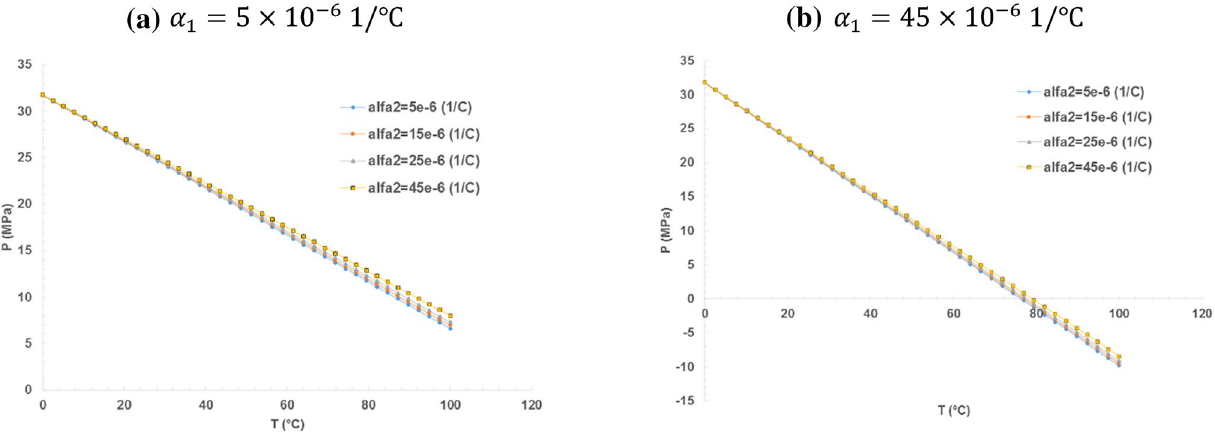
Fig. 13 Effect of different values of 𝛂 2 on the burst pressure of repaired pipe at: a low values of 𝛂 1 , b high values of 𝛂 1